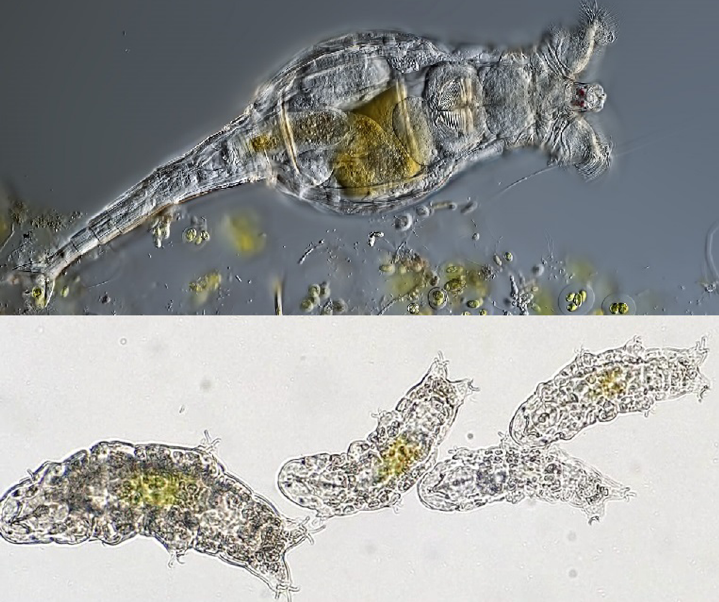
Fig 1. Photomicrographs of 2 of the animals discussed here. The bdelloid rotifer Rotaria macrura (top) and the tardigrade Hypsibius dujardini (bottom). Image credits: Michael Plewka and Kazuharu Arakawa.